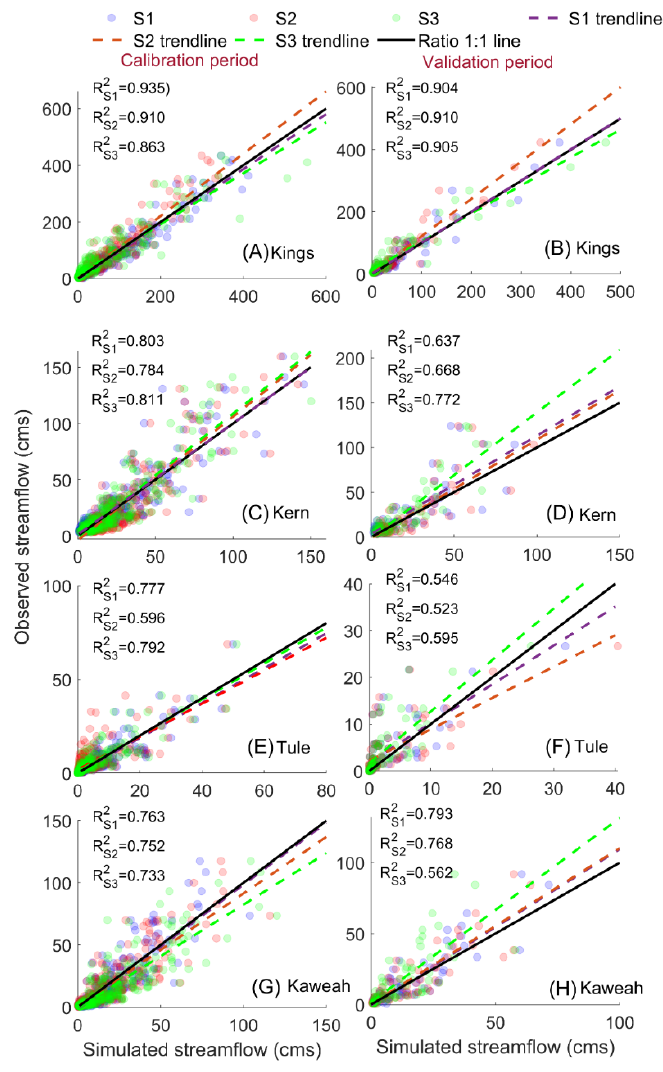
Figure 4. Scatter plots (with trendlines and R 2 ) for the simulated versus observed monthly streamflows for the three calibration scenarios for the calibration period (1984–2007, left column) and validation period (2008–2013, right column). Rows show results for the Kings ( A -calibration, B -validation), Kern ( C -calibration, D -validation), Tule ( E -calibration, F -validation), and Kaweah ( G -calibration, H -validation) watersheds, respectively. R 2 refers to Coefficient of Determination, and S1–S3 refers to Scenario 1–Scenario 3.